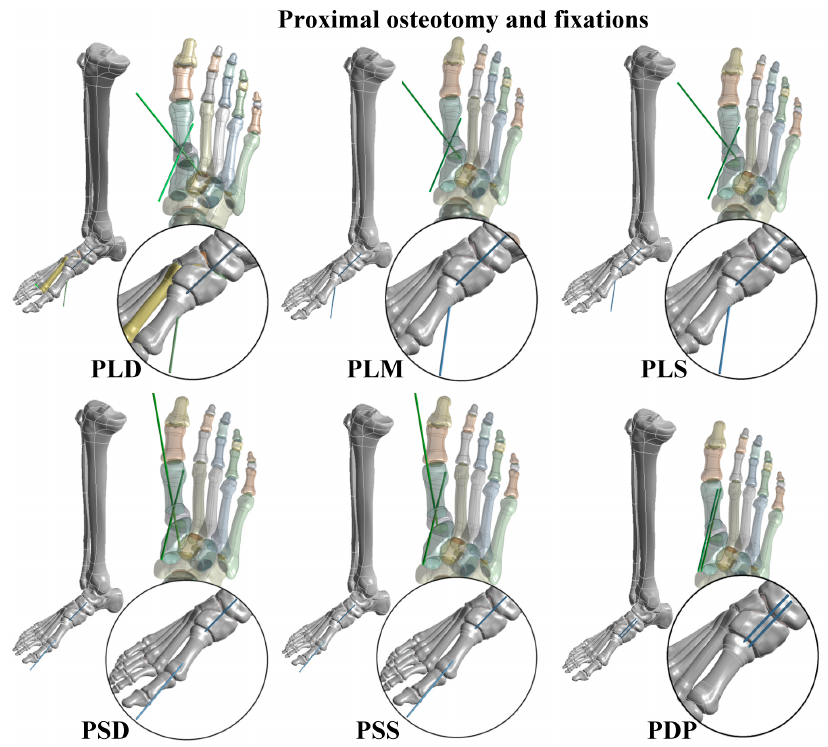
Figure 2. Six types of proximal metatarsal osteotomy (PMO) and Kirschner wire fixation strategies.